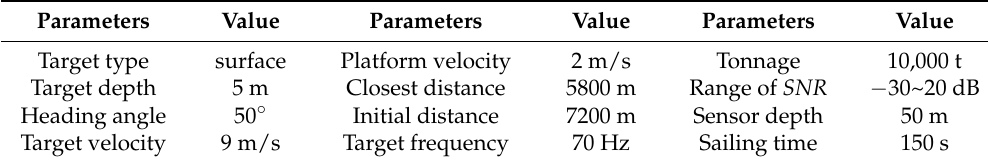
Table 2. Target simulation parameters of the surface target.